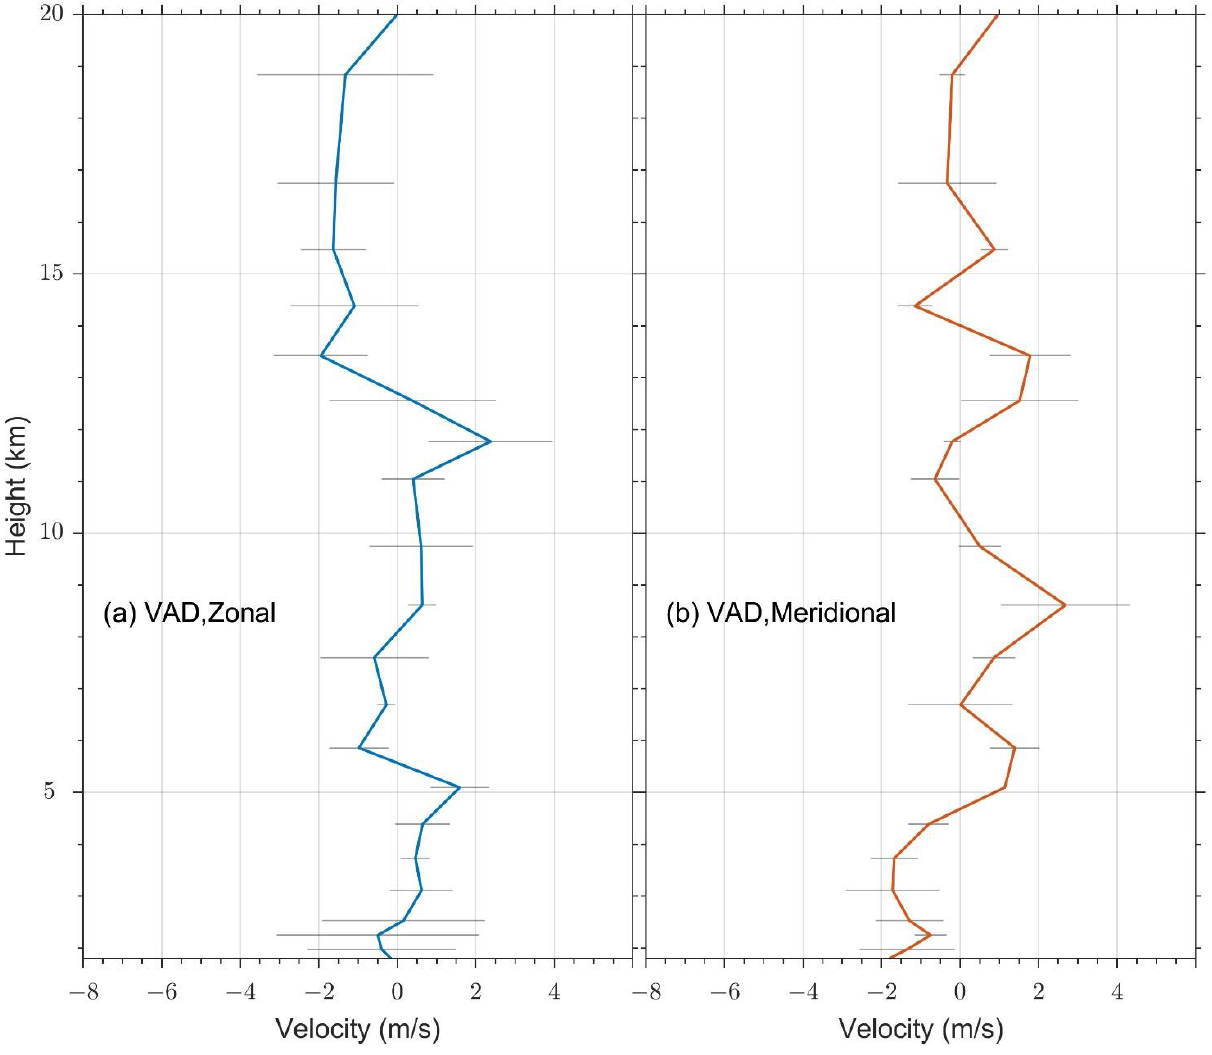
Figure 8. Daily height distribution of zonal wind average deviation ( a ) and meridional wind average deviation ( b ) derived by the VAD methods for zenith angle 6° on 21 July 2021, in experiment #3. Error bars represent 1 –σ standard deviation.